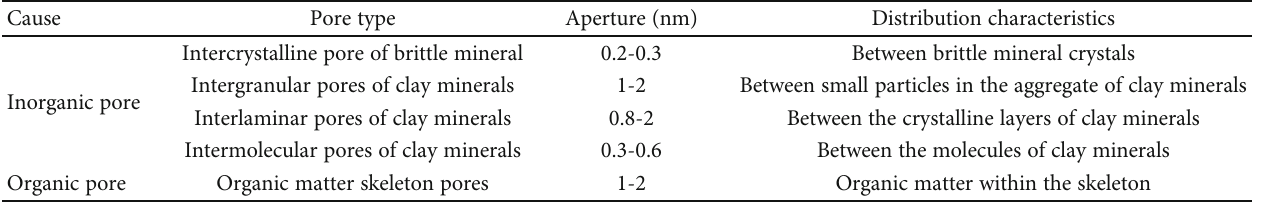
Figure 8: Relationship between the organic carbon content and pore volume ratio. Table 3: Classi fi cation of micropore